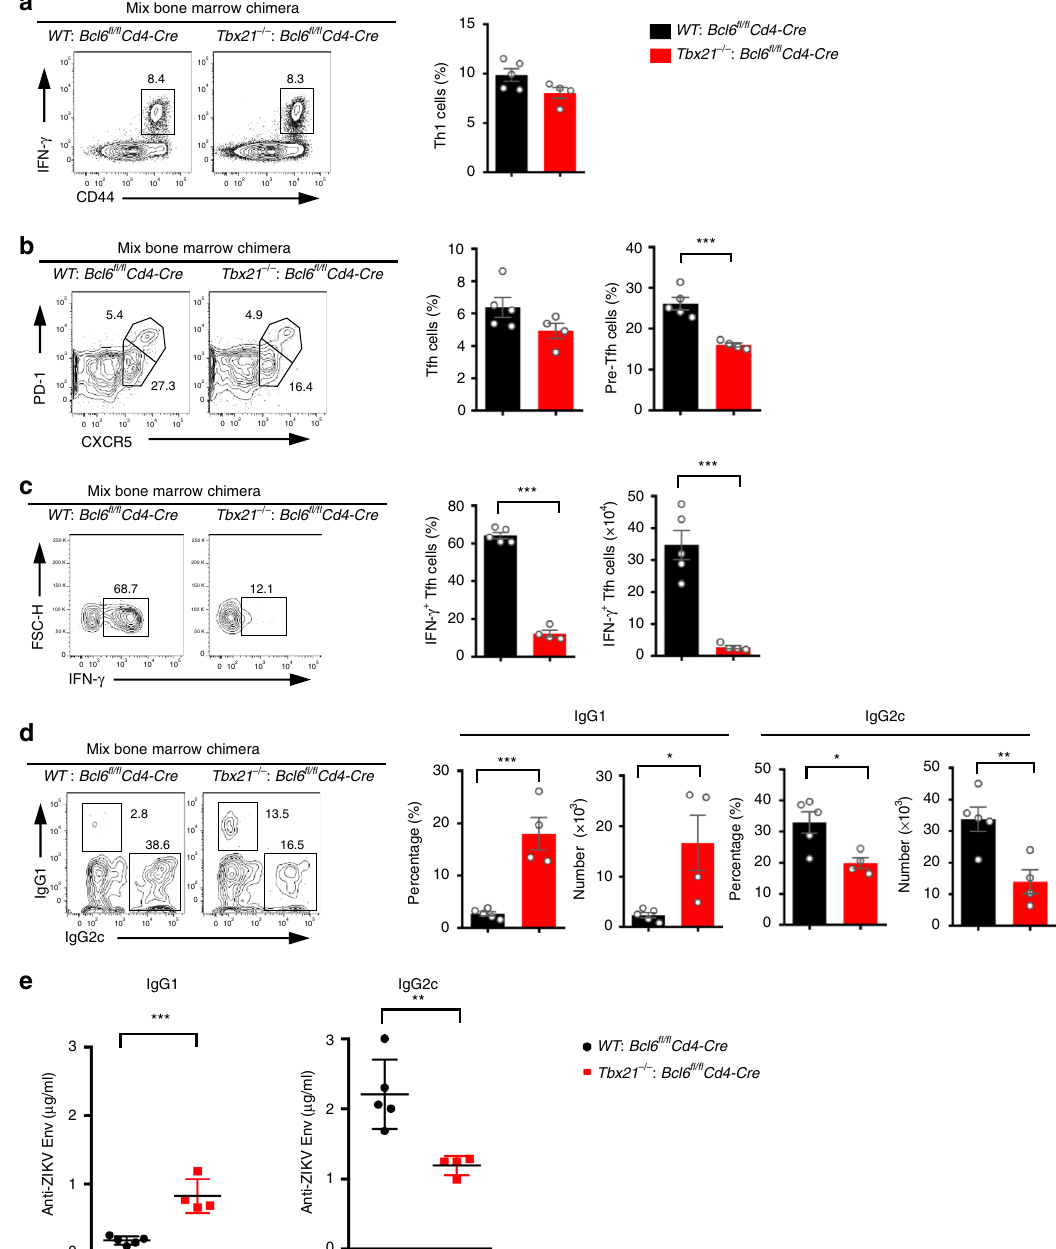
Fig. 6 Th1-like Tfh cell is required for IgG2c antibody class switching. Mixed bone marrow chimeras ( WT: Bcl6 fl / fl Cd4- Cre; and Tbx21 − / − : Bcl6 fl / fl Cd4- Cre) were administered with anti-IFNAR1 antibody one day prior to ZIKV infection. Splenocytes and sera were collected on 14 dpi for measurement of Tfh cell and antibody responses, respectively ( n = 5 for WT: Bcl6 fl / fl Cd4- Cre group and n = 4 for Tbx21 − / − : Bcl6 fl / fl Cd4- Cre group). a Representative fl ow cytometry plots of IFN- γ + cells in CD4 + CXCR5 − T cells were presented as Th1 cells (left panel); bar graphs summarized the percentages of Th1 cells in each group (right panel). b Representative fl ow cytometry plots of CXCR5 high PD-1 high cells and CXCR5 medium PD-1 medium in CD4 + CD44 high CD62L low T cells were presented as Tfh cells and pre-Tfh cells (left panel); bar graphs summarized the percentages of cells in each group (right panel). c Representative fl ow cytometry plots of IFN- γ staining in CXCR5 high PD-1 high Tfh cells (left panel); the percentages and numbers of IFN- γ + Tfh cells were summarized by bar graphs (right panel). d Representative fl ow cytometry plots of IgG1 and IgG2c intracellular staining in B220 low CD138 + IgD low cells (Left panel); bar graphs summarized the percentages and numbers of IgG1 + and IgG2c + cells (right panel). e The concentrations of ZIKV envelope speci fi c IgG1 and IgG2c antibodies in chimeras were measured by ELISA. The summary data were presented as mean ± SEM. Statistical differences were determined by Student ’ s t test and p values were indicated by * p < 0.05, or ** p < 0.01, or *** p < 0.001. Data ( a – e ) are pooled from two independent technical duplicates. Source data are provided as a Source Data fi